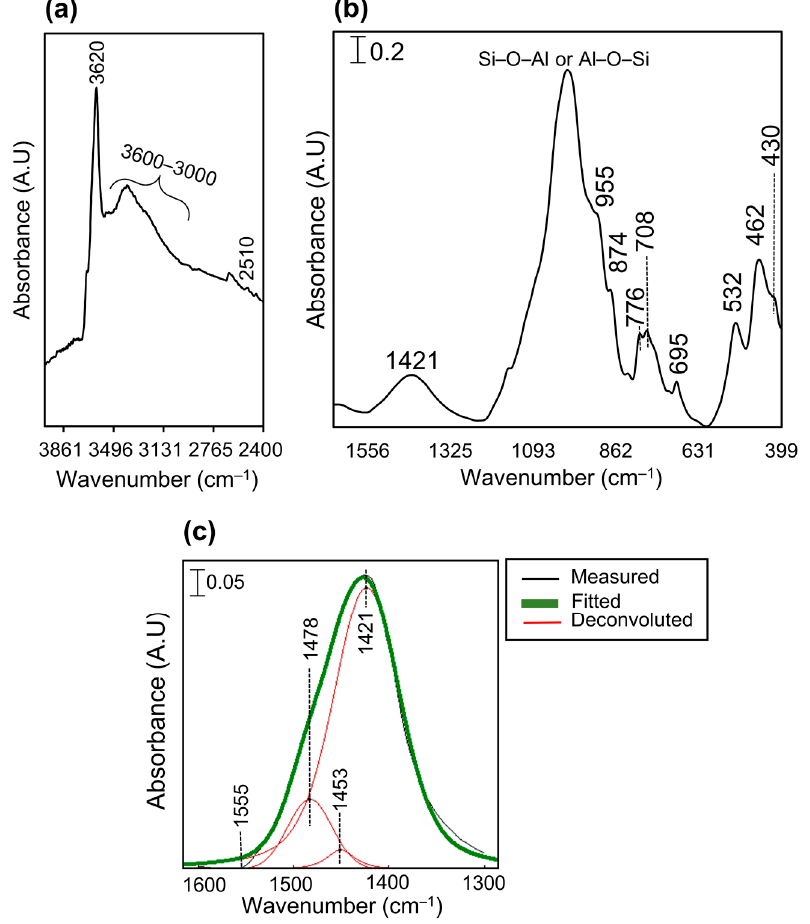
Figure 4. FTIR spectrum of the ASGM tailings sample: ( a ) 4000–2400 cm − 1 , ( b ) 1600–399 cm − 1 , and ( c ) deconvoluted spectrum between 1650 and 1250 cm − 1 .